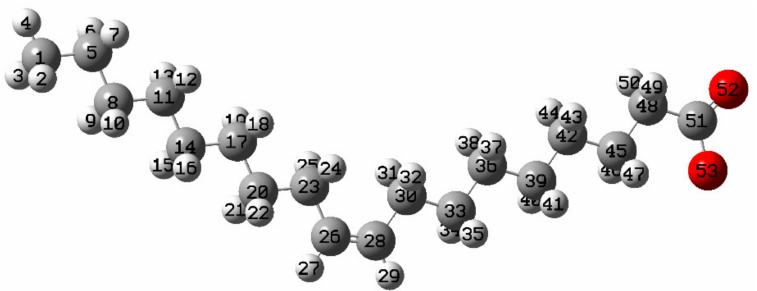
Figure 1. Single oleate molecule with − 1e total